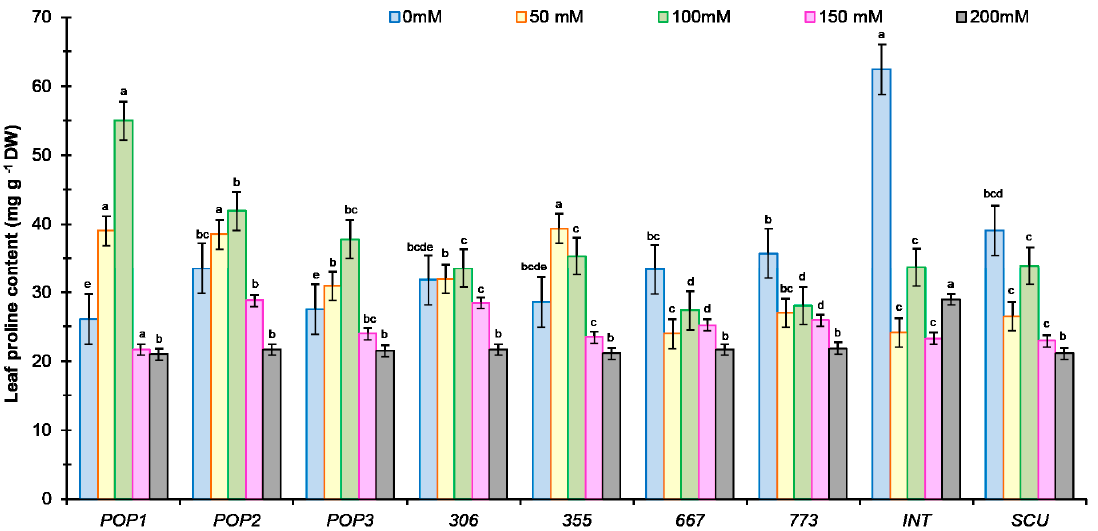
Figure 7. Effect of salt stress concentrations (0, 50,100, 150, 200 mM NaCl) on proline content in leaves for seven populations of M. ciliaris ( Pop1, Pop2, Pop3, 306, 355, 667, 773 ), one population of M. intertexta ( M. int ), and one population of M. scutellata ( M. scut ). The means are averages of n=5. The standard deviation annotated by different lower-case letters in the same stress type indicate significant differences at p < 0.05 according to Tukey’s post hoc test.